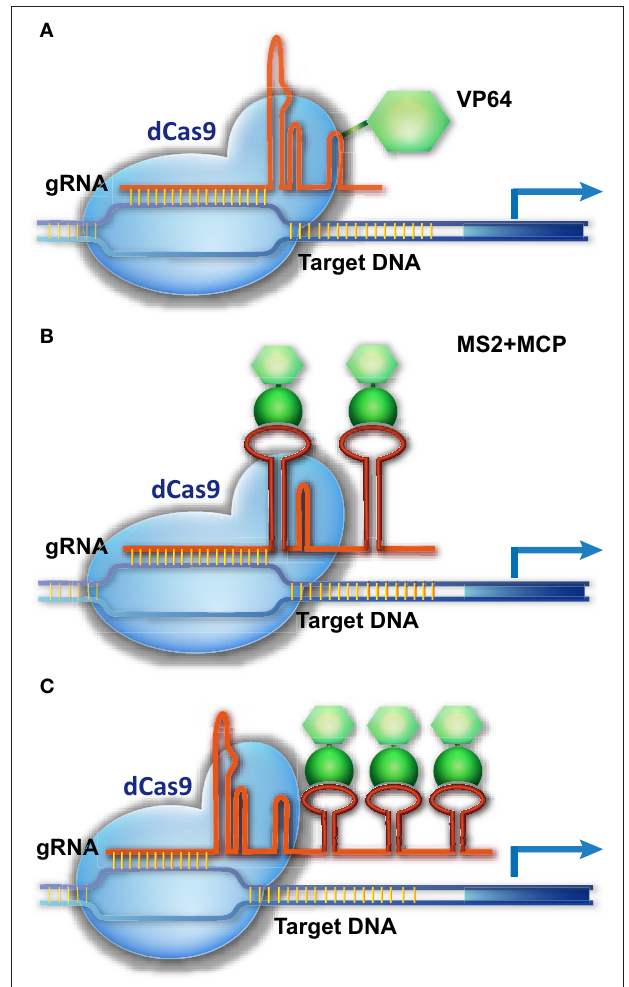
FIGURE 3 | CRISPR/Cas9-based transcriptional activation of target genes. (A) The dCas9-AD is guided to the promoter of a target gene, activating transcription. (B,C) A three-component system for target gene activation. The gRNA is modified by adding an RNA ligand, MS2, to its loop or 3 ′ -end, without impairing its binding to dCas9. MCP, which specifically binds the MS2 ligand, is fused with the AD fragment. The dCas9/gRNA-MS2 is directed to the promoter of the target gene and recruits MCP-AD to activate